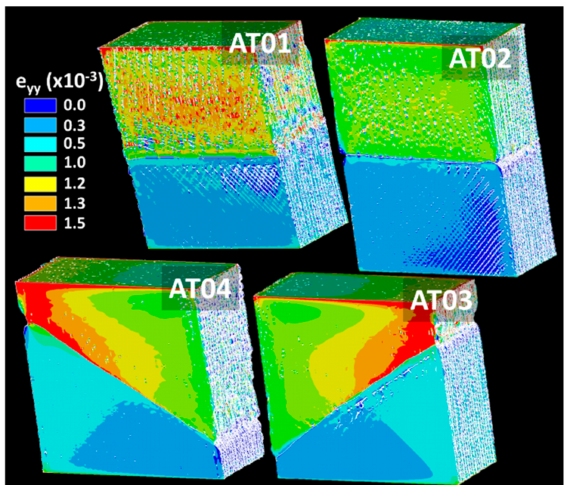
Figure 18. Longitudinal strain component as a function of the printing orientation and number of intertwining